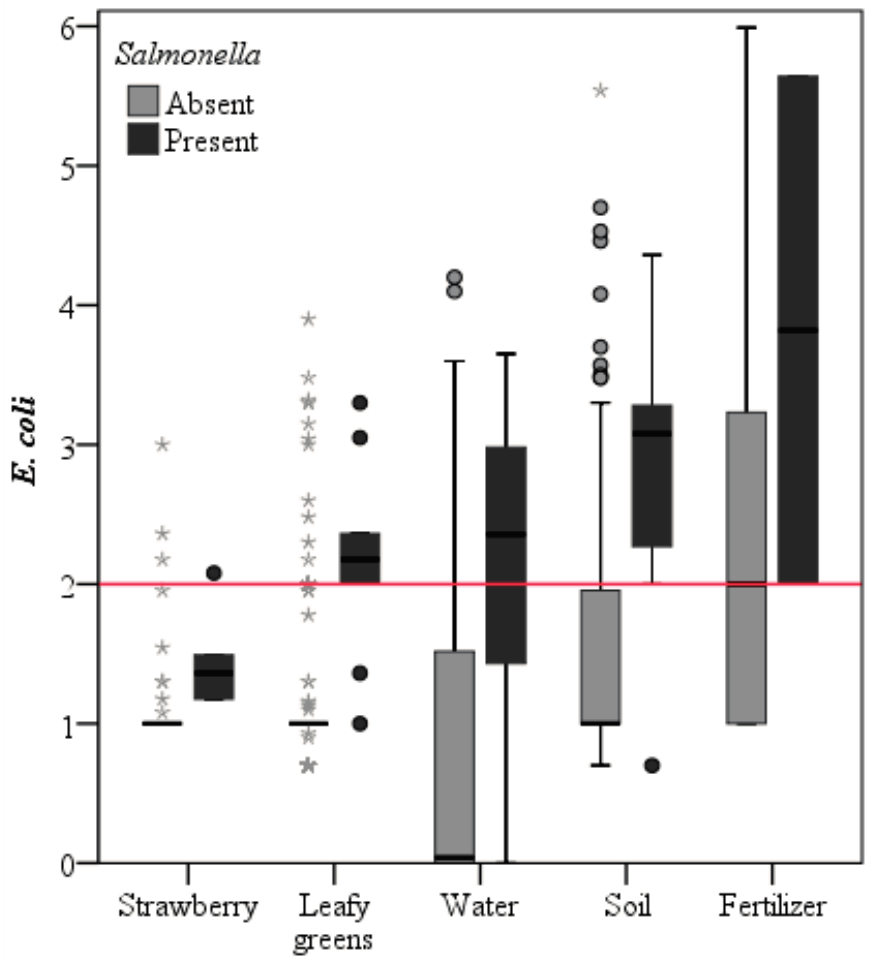
Figure 1. Pathogens were associated with higher generic E. coli counts (in log CFU/g or 100 mL), exemplified here by showing all Salmonella analyses per sample type (except for seeds and contact surfaces, since these were always negative). The horizontal red line indicates the threshold of 100 CFU E. coli per gram or 100 mL to show the potential impact of setting this value as a limit. Outliers are presented as circles (1.5 to 3 times the interquartile range below the 25th percentile or above the 75th percentile) or as asterisks (more than three times the interquartile